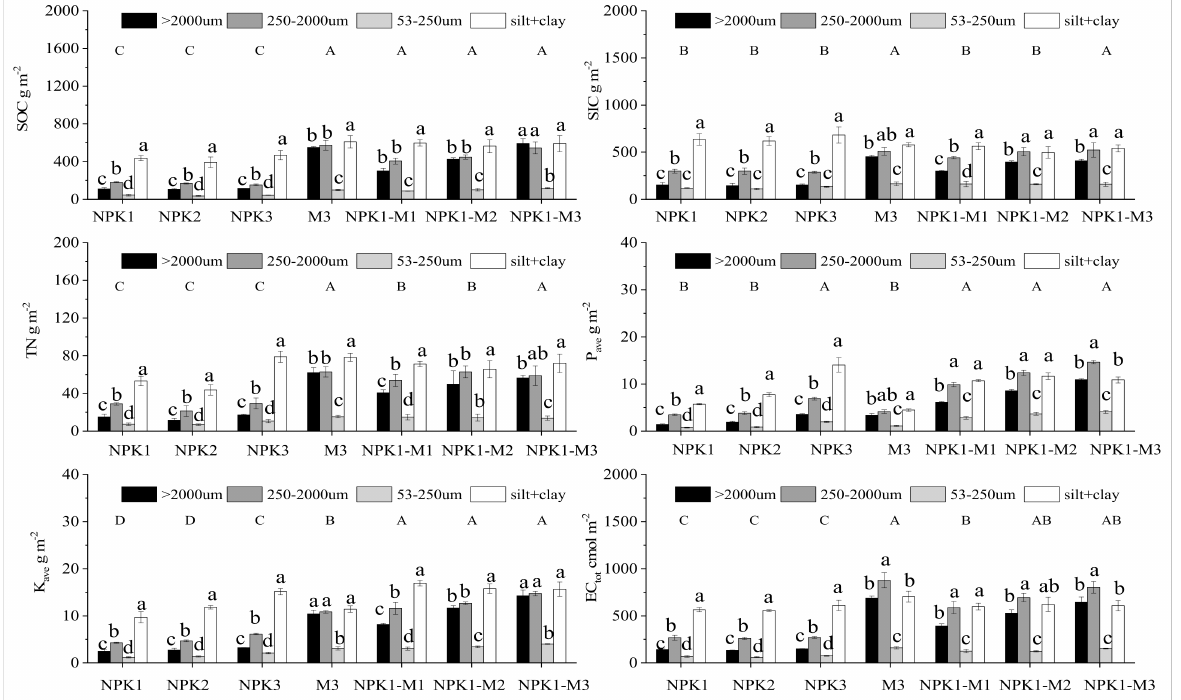
Figure 3. The effect of long-term fertilization on the SOC, SIC, TN, P ave , K ave and EC tot stocks within aggregates fractions. Bars represent the mean + standard error ( n = 3). Different letters indicate significant differences among the treatments ( p <